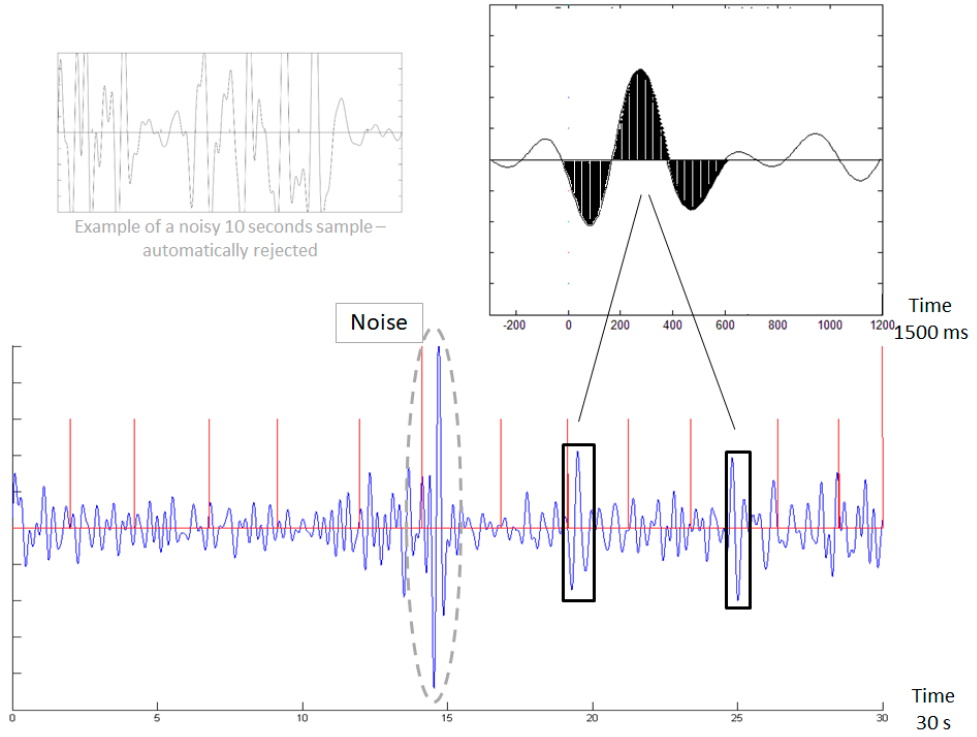
Figure 1. Demonstration of template matching.